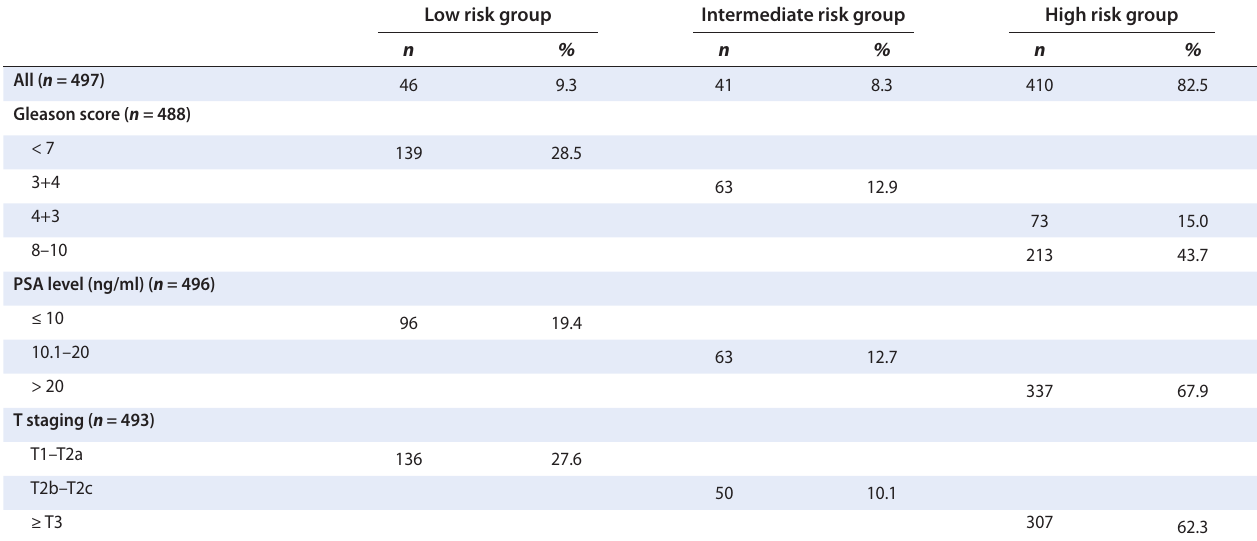
Table 3: Risk group stratification of patients with prostate cancer according to their Gleason scores, PSA levels, and T staging